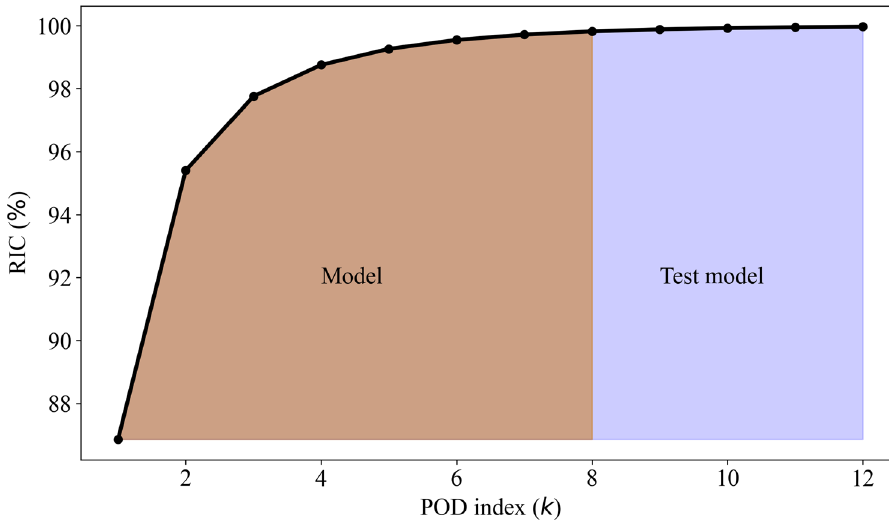
Figure 3. Relative information content (RIC) values as a function of the POD index. Test scales,which are used to build our reward function, represent the contribution of the under-resolved ROM